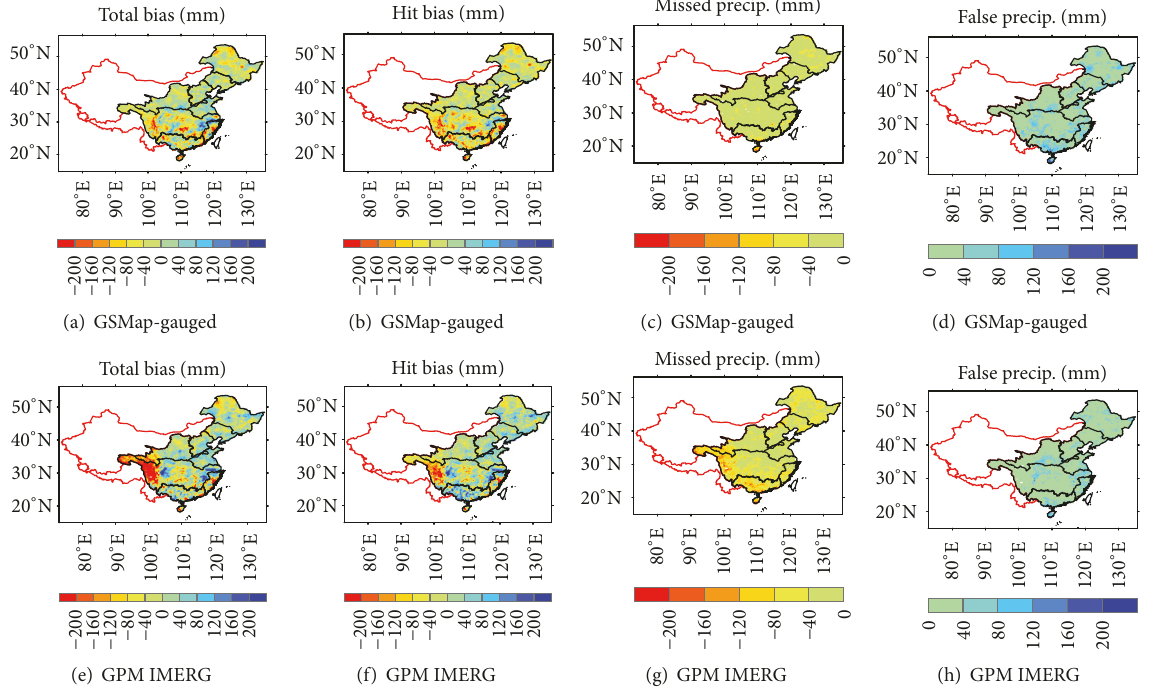
Figure 3: Total bias and three error components of GSMap-gauged and IMERG precipitation data for the summer (JJA) over two years (2014 and